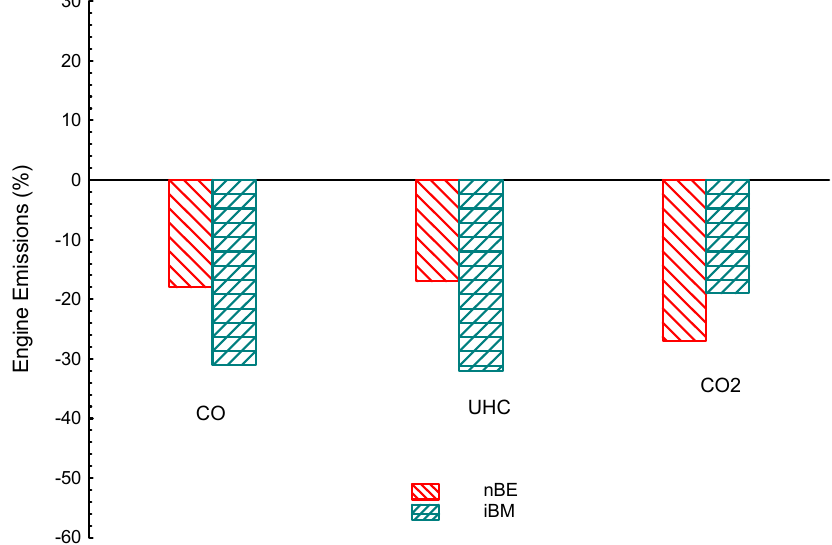
Figure 6. Comparison of CO, UHC and CO 2 emissions for i-butanol–bio-methanol–gasoline blends (iBM), n-butanol–bio-ethanol–gasoline blends (nBE) and neat gasoline (baseline) on average basis.